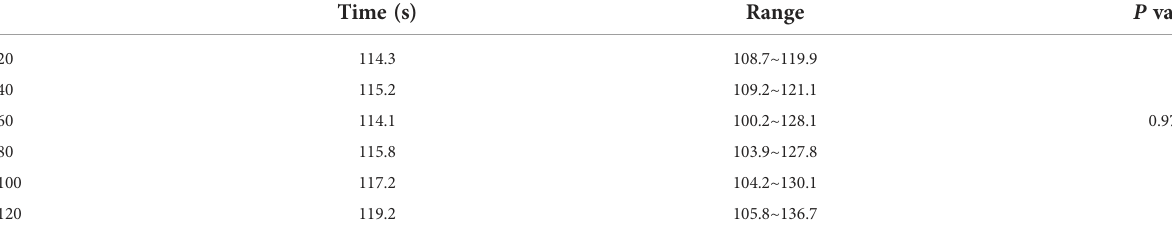
TABLE 7 The time of ABAS automatic segmentation among different atlas library